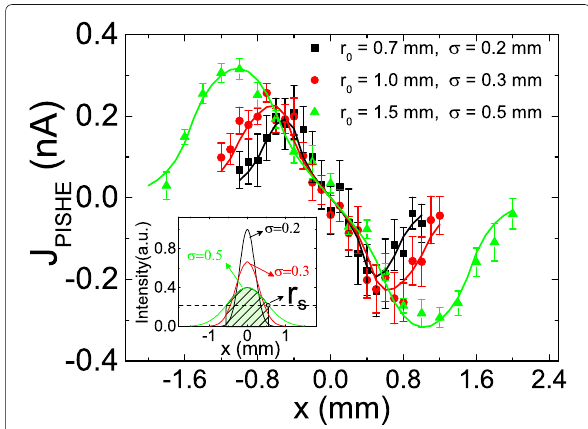
Fig. 3 PISHE current as a function of light spot location under different Gaussian light profiles when the light power is 250 mW. The inset shows the distribution of light intensity for different Gaussian light profiles. The dashed line indicates the absorption saturation intensity of the sample